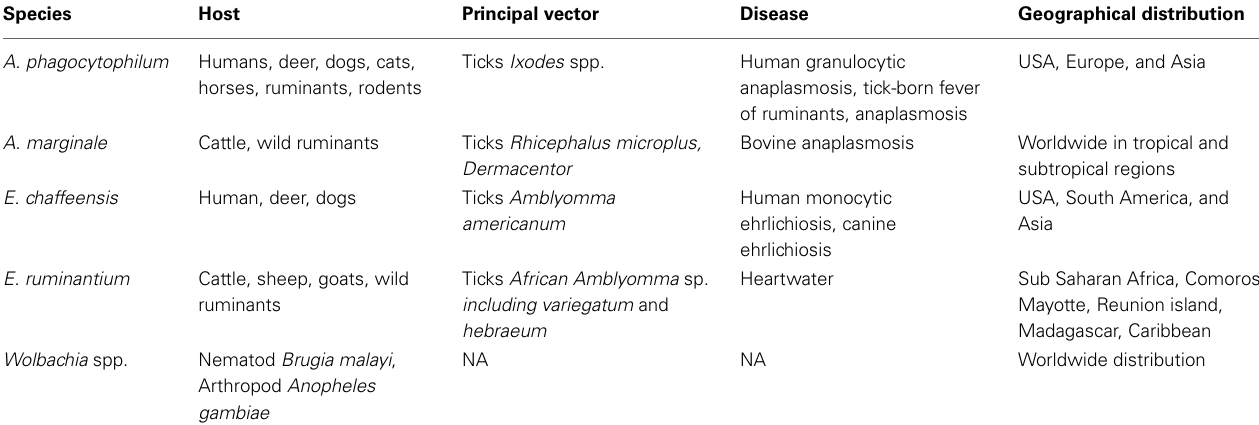
Table 1 | Hosts, vectors, geographical distribution, and associated diseases for selected Anaplasmataceae spp.